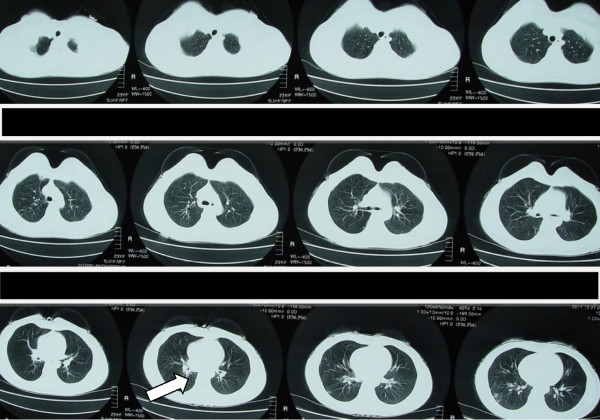
The right lower lobe was gradually stretched to fully open after dilation (arrow). (27 December 2011)